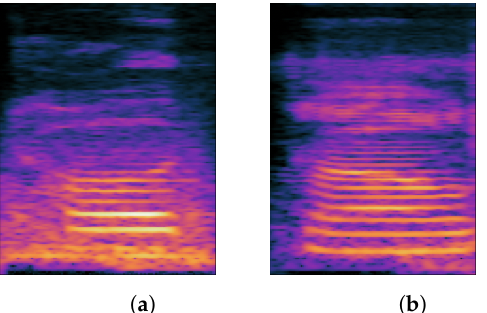
Figure 1. Spectrum comparison of stopping and correct: ( a ) stopping; ( b ) correct.